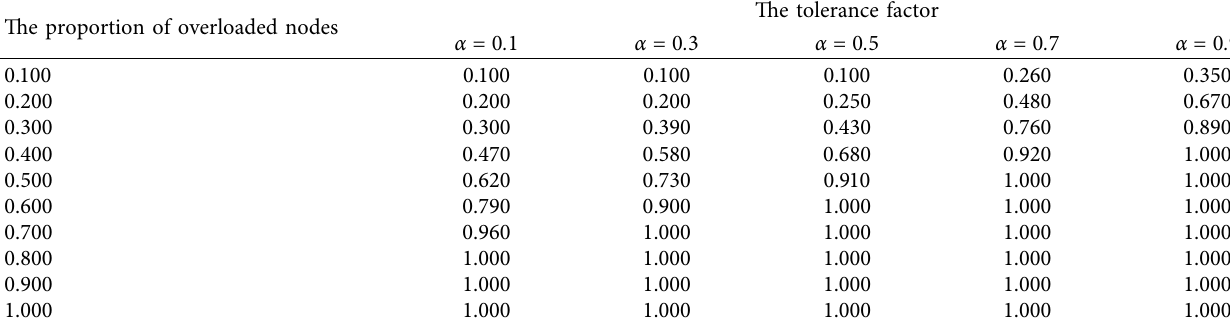
Table 12: The proportion of abnormal nodes